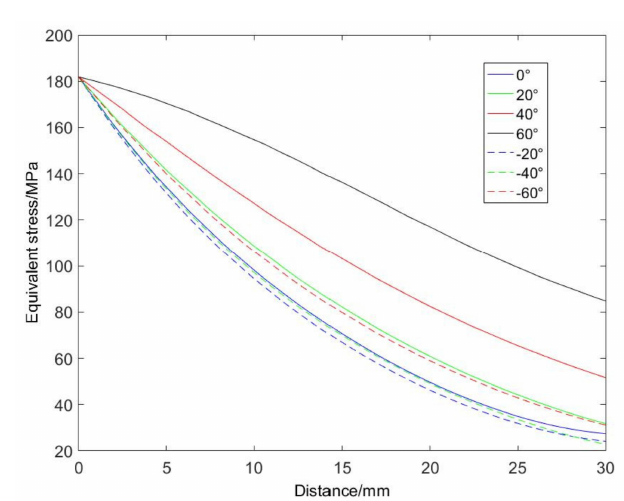
Figure 17. Stress–distance curve of each